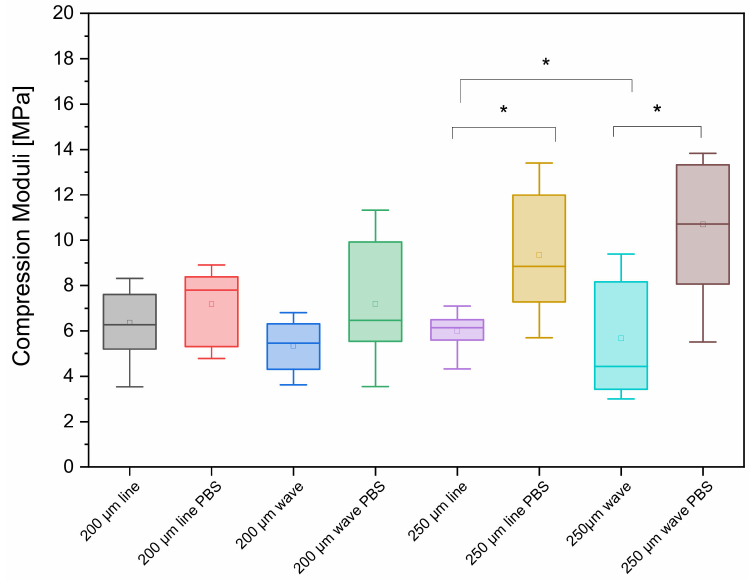
Figure 7. Comparison of the compression moduli of the different samples; * indicates statistical significance at p < 0.05.